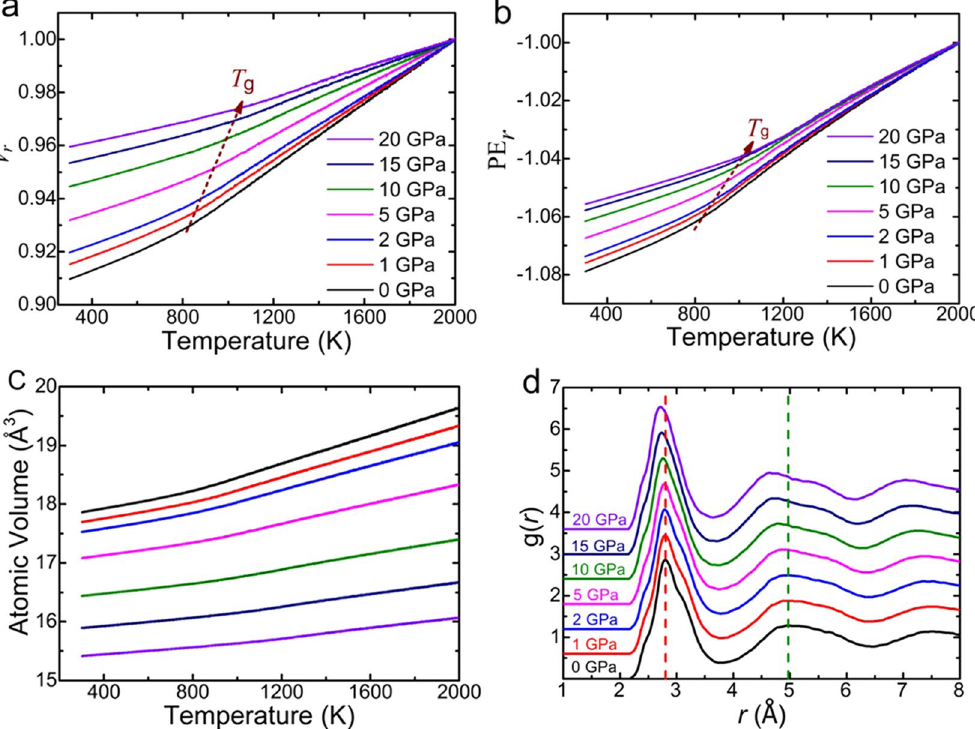
Figure 5. Description of glass transition of Zr 50 Cu 44 Al 6 alloy in MD simulations. ( a ) The reduced volume V r and ( b ) the reduced potential engergy PE r against the temperature show an elevated glass transition temperature with the increasing hydrostatic pressure. ( c ) The atomic volume contracts at a certain temperature due to the applied hydrostatic pressure. In other words, the Zr 50 Cu 44 Al 6 MG is densified, which is proved by the shift of the first and second peak position towards a smaller radial distance on the g ( r ) curve shown in ( d